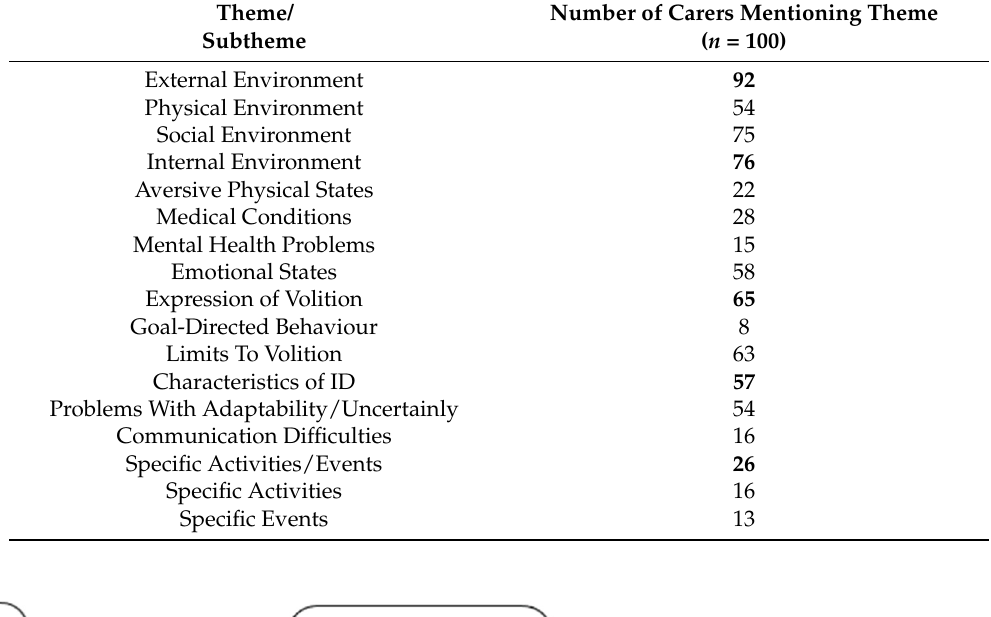
Table 3. Prevalence of themes and subthemes detected at stage 1 [36].